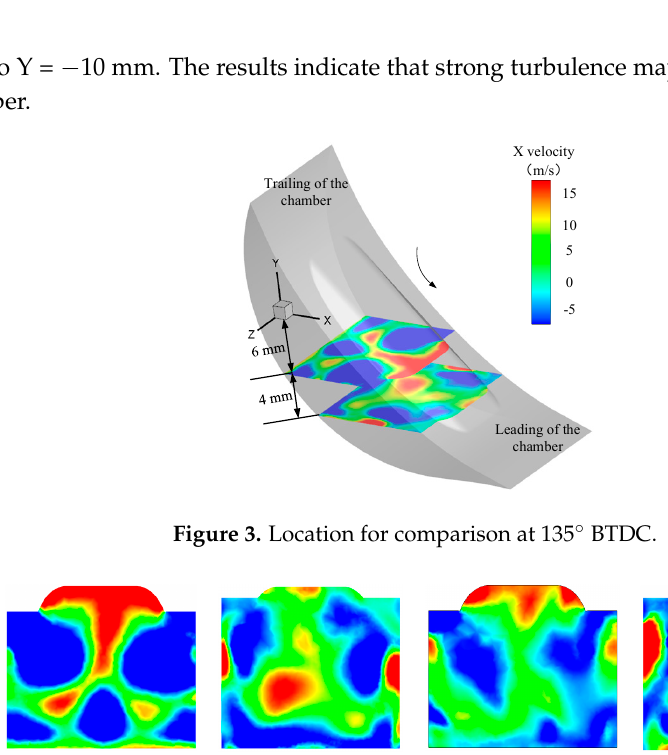
Figure 3. Location for comparison at 135° BTDC.